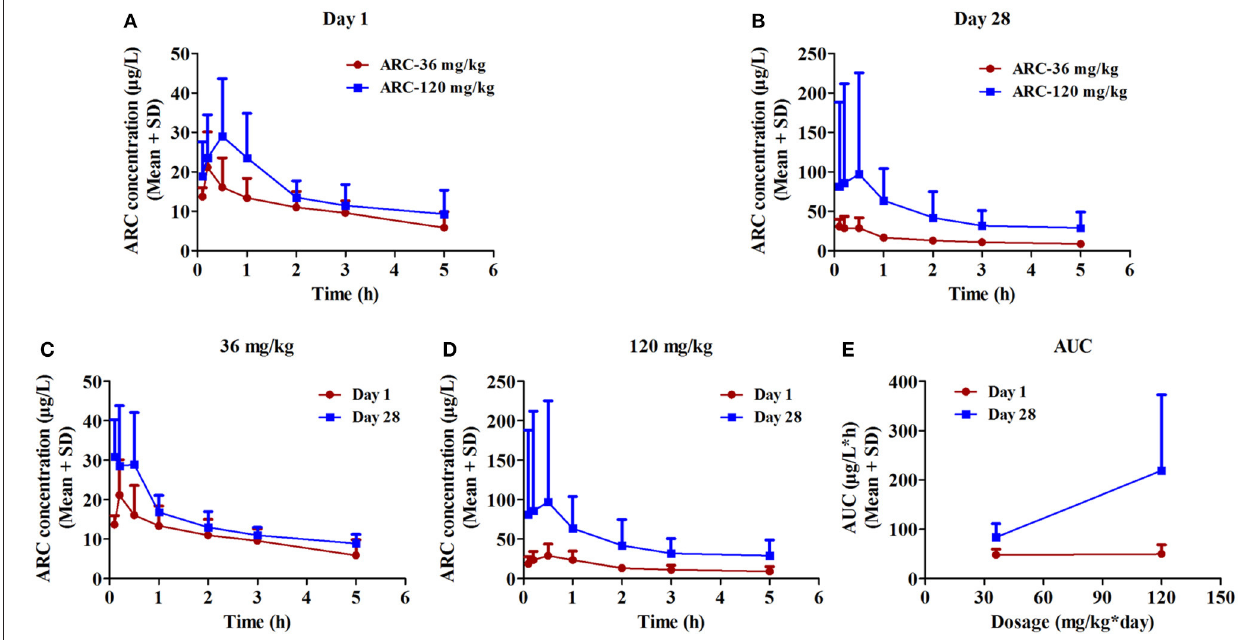
FIGURE 4 | The plasma concentration vs. time profiles of Arctigenin in rats after the first (A) and last (B) intragastric administrations by Arctigenin at different doses. The plasma concentrations of Arctigenin in rats’ plasma after i.g Arctigenin at the dosage of 36 mg/kg/day (C) , and 120 mg/kg/day (D) . (E) The exposed quantity of Arctigenin . ( n = 10 in per treatment group; results are presented as the mean + SD).